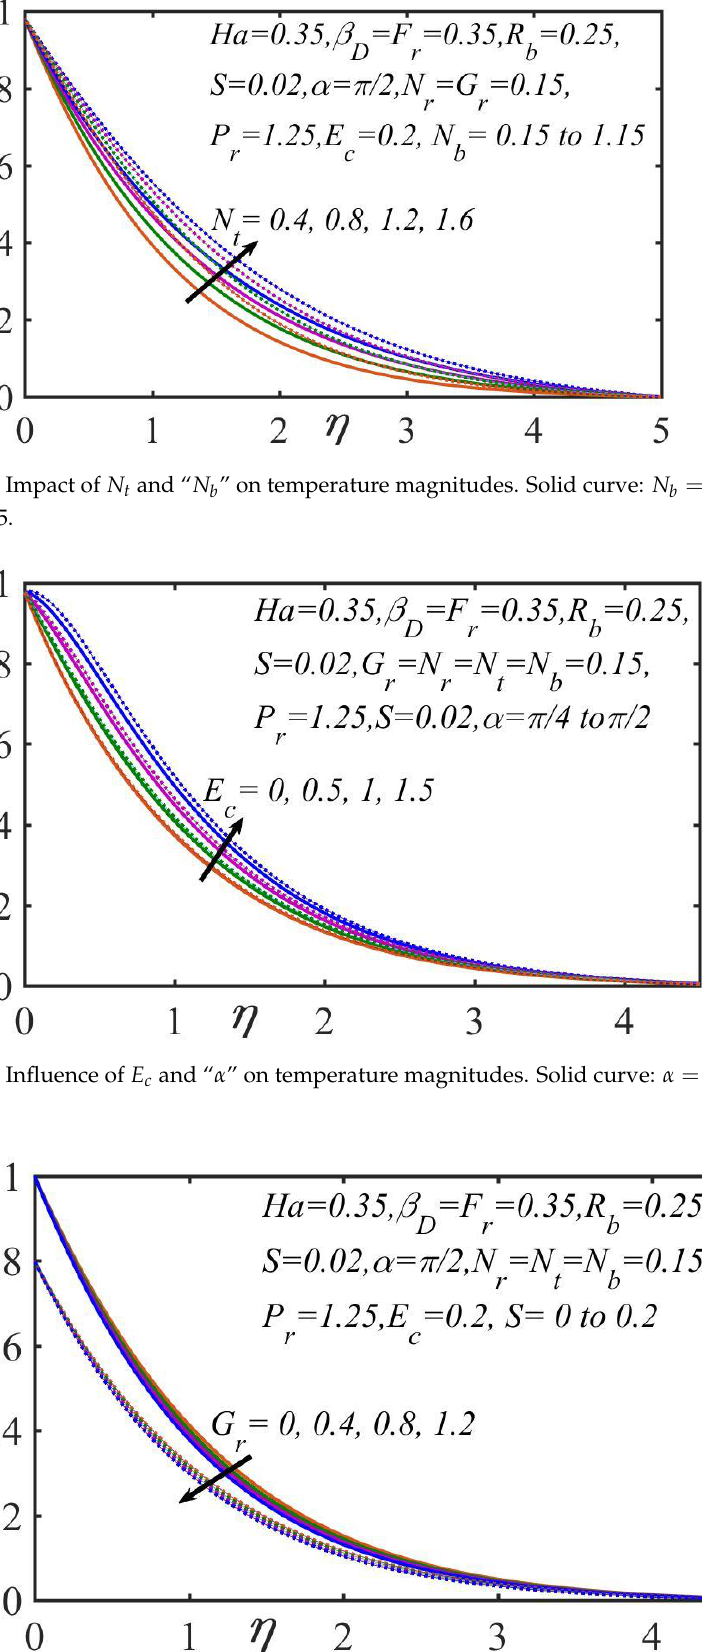
Figure 6. Impact of 𝑃 𝑟 and 𝐻𝑎 on temperature magnitudes. Solid curve: 𝐻𝑎 = 0 ; dotted curve: 𝐻𝑎 = 0.5 .